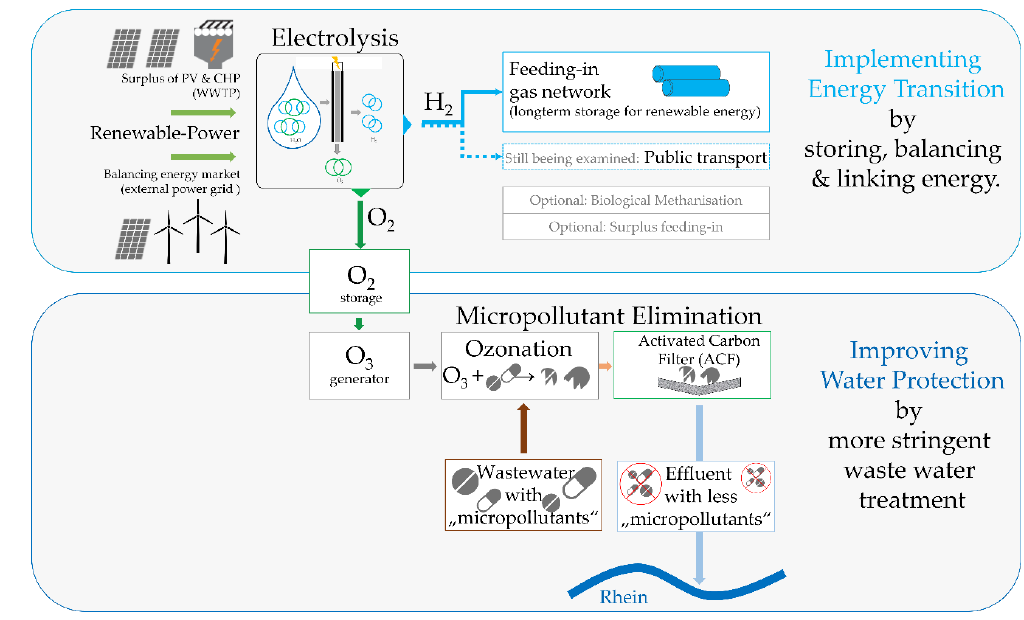
Figure 4. Process chain of the “arrived” project.